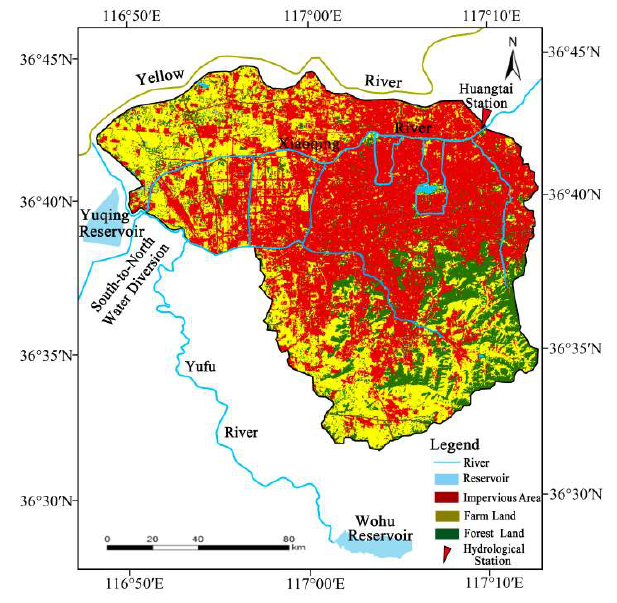
Figure 1. Location of Xiaoqing River in Jinan and drainage map.